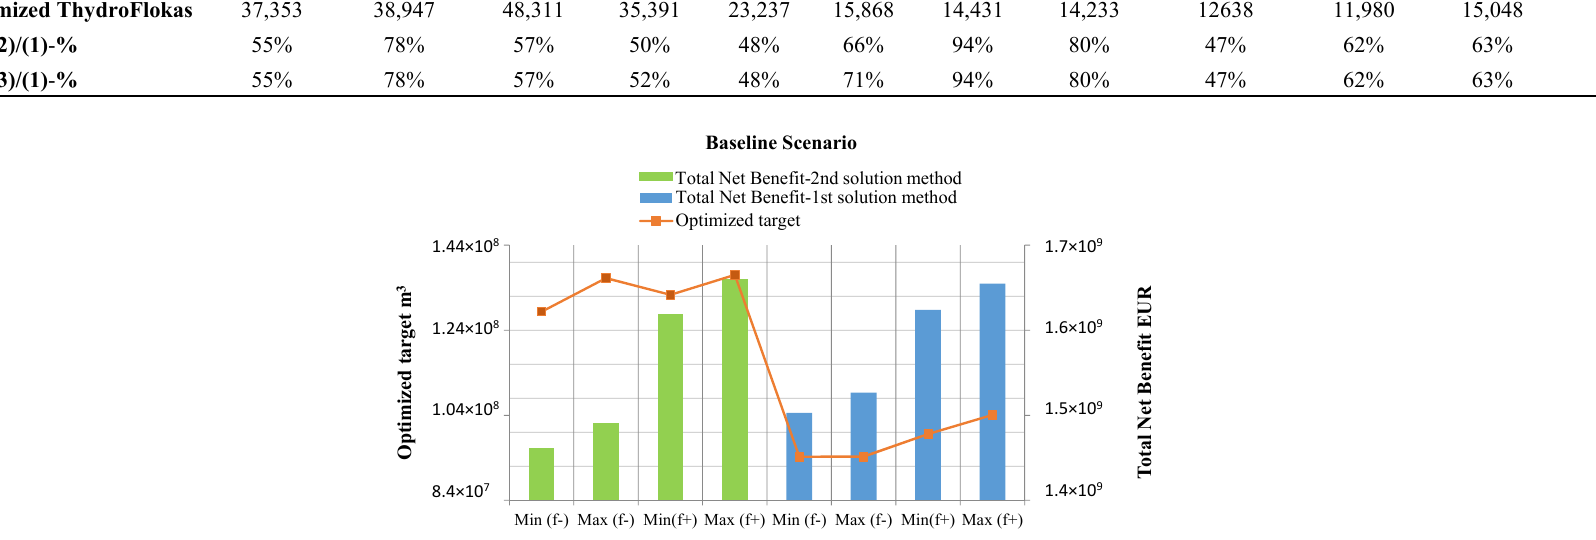
Figure 3. Interconnections between total net benefit and optimized total target for the four options and for both solution methods.